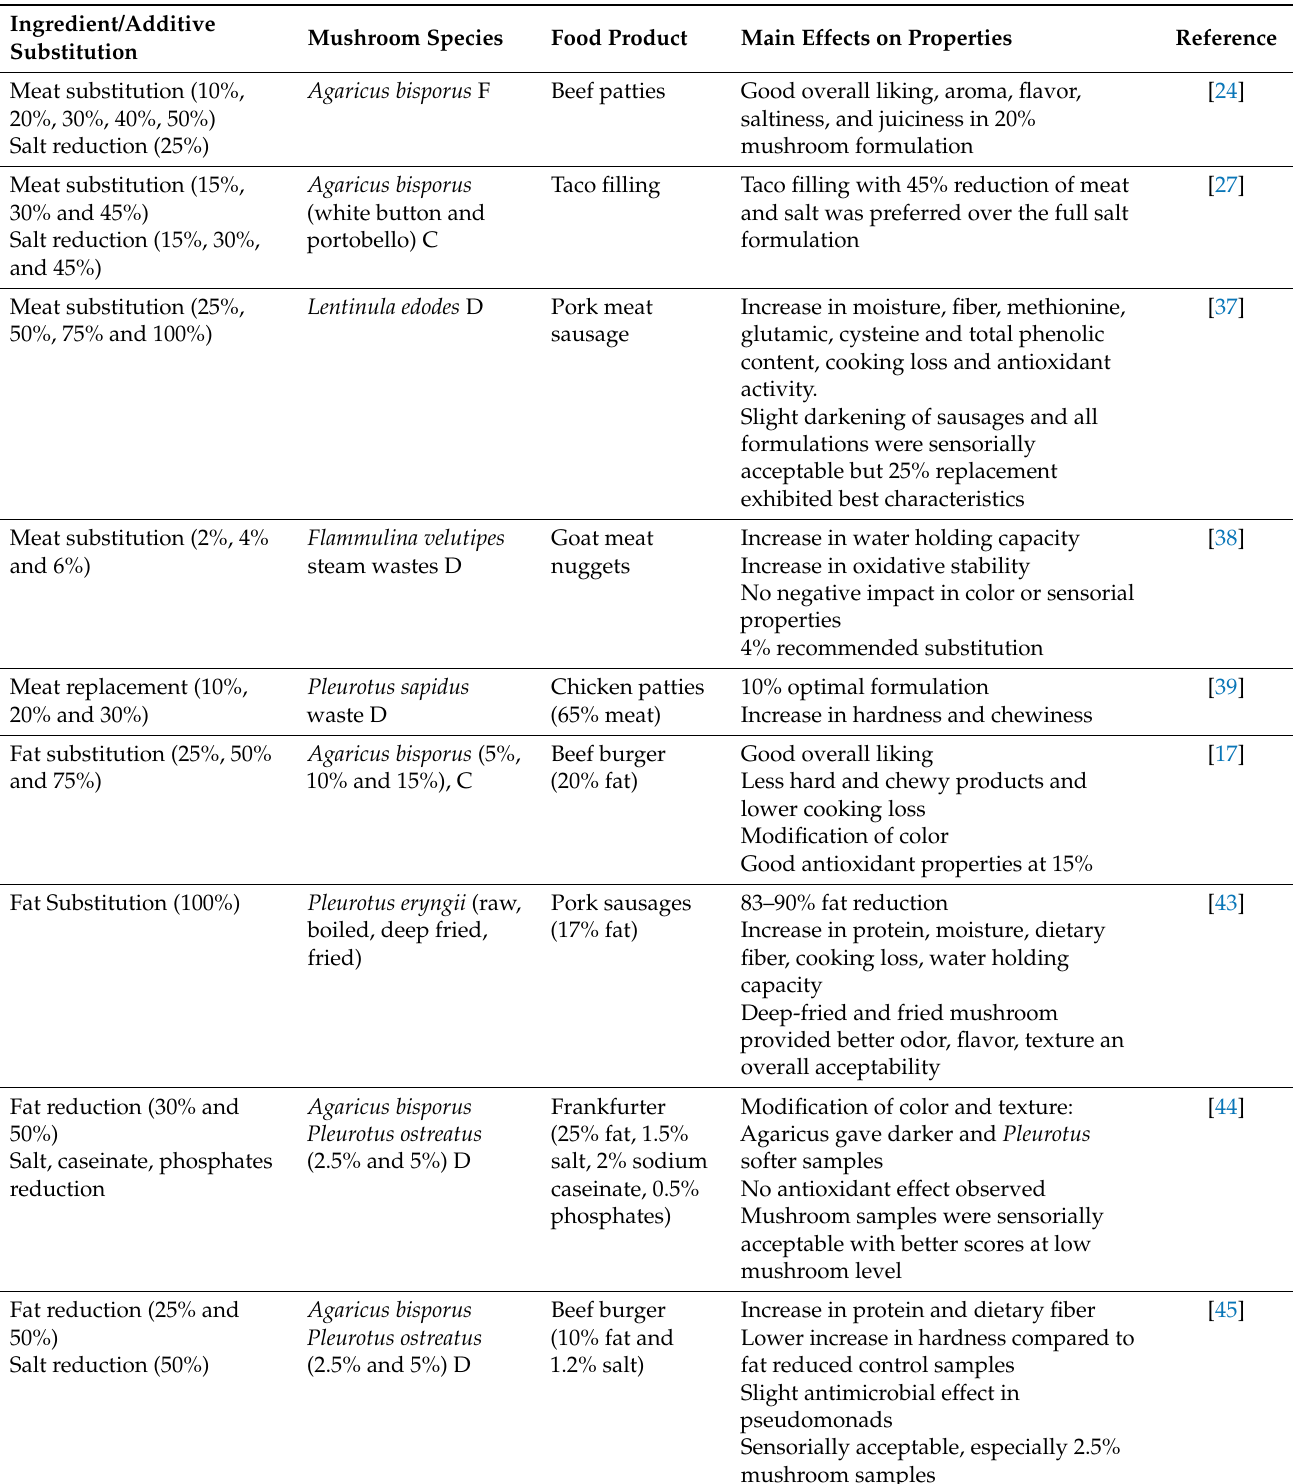
Table 1. Recent works with edible mushroom species as food ingredient/additive replacers (last 5